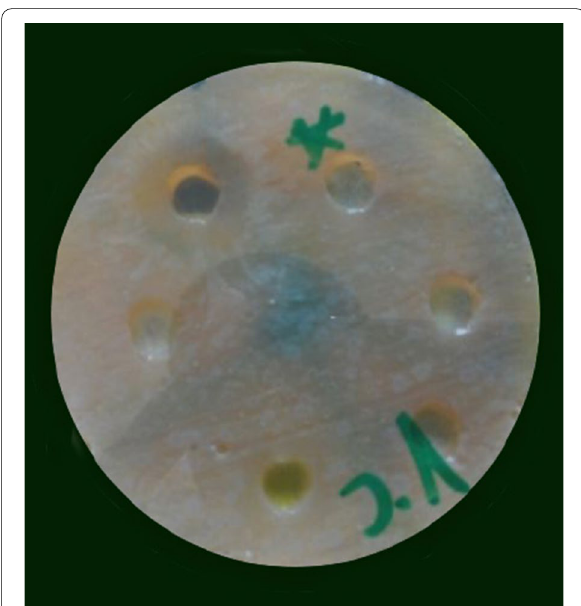
Fig. 8 Antagonistic effect of Metschnikowia pulcherrima on Salmonella